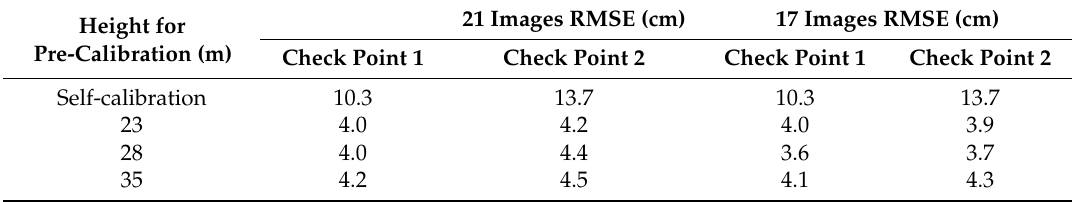
Table 12. The residuals of 2 CPs for an oblique flight when using self-calibration and pre-calibration at 23 m, 28 m and 35 m